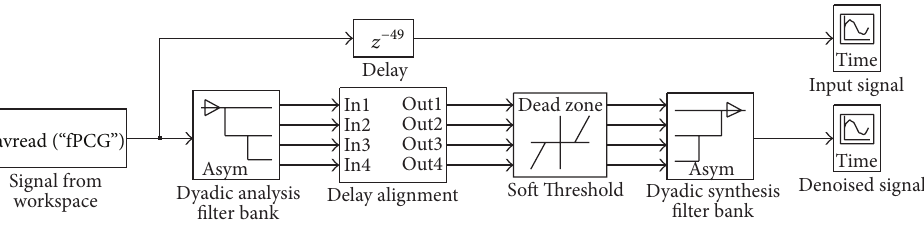
Figure 8: Simulink model for wavelet